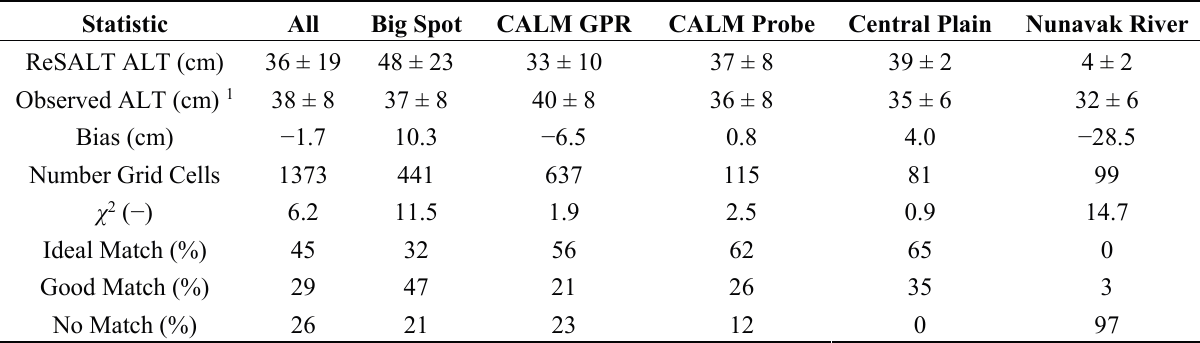
Table 3. Comparisons between ReSALT and GPR ALT at the four validation sites. Statistic